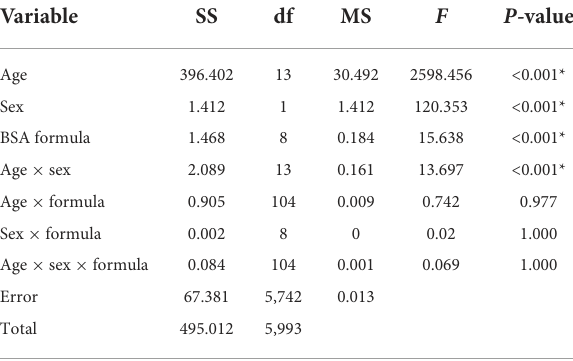
TABLE 3 Analysis of variance results for age, sex and formula main effects and interaction